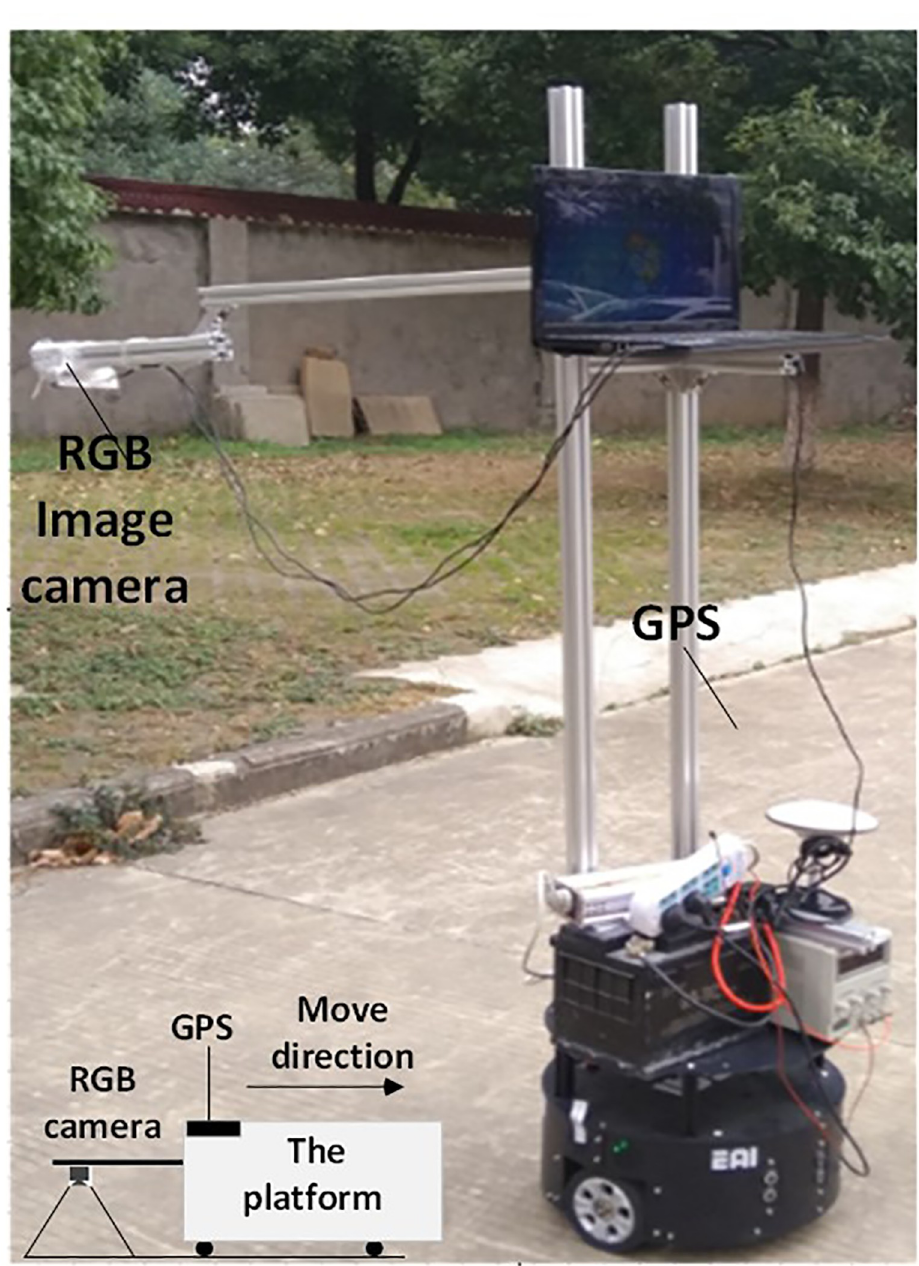
Fig 6. The developed mobile platform for crack data